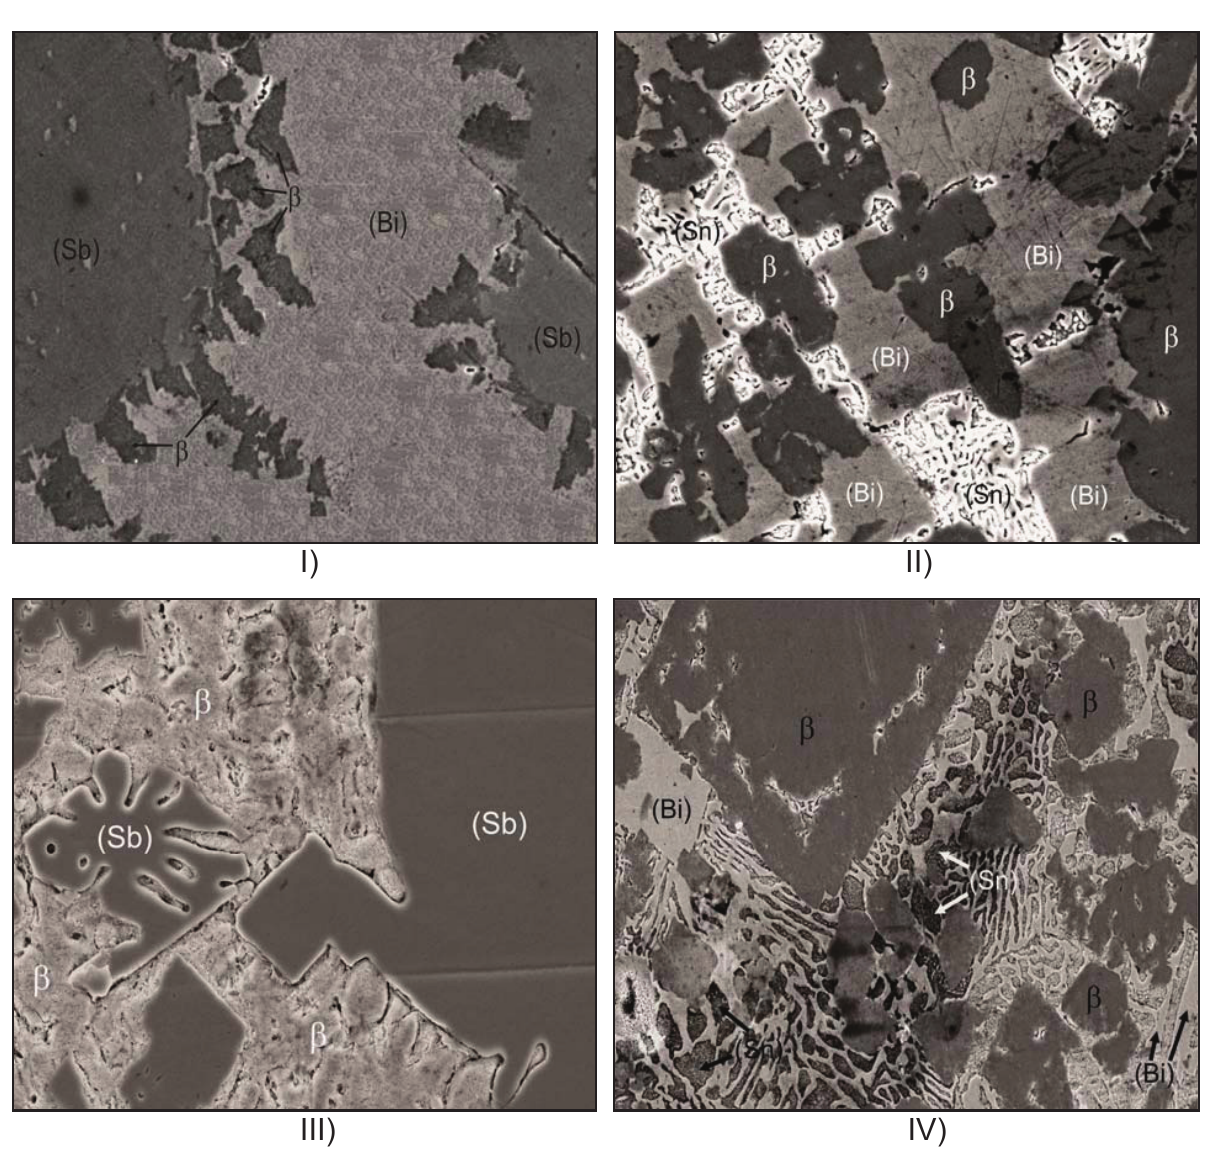
Figure 6. SEM micrographs illustrating microstructures of investigated alloys. SEM images of the microstructures of the selected